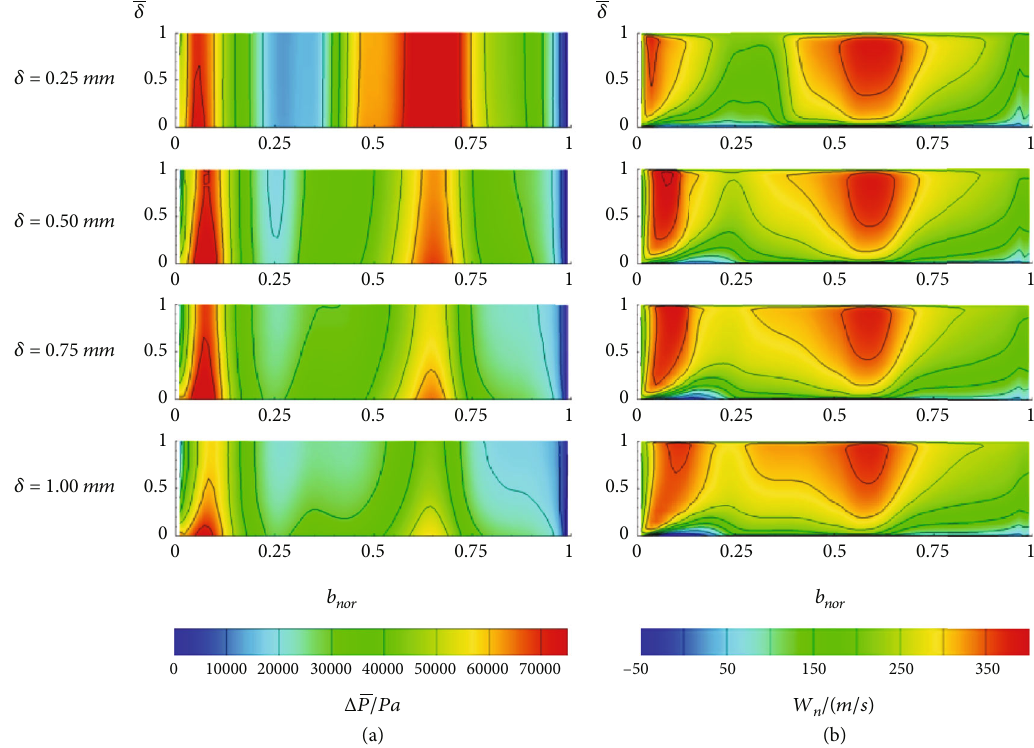
Figure 27: Distribution of the fl ow parameters at the tip clearance of RotorSD. (a) Distributions of the pressure di ff erence. (b) Distributions of relative velocity perpendicular to the pressure surface at the blade